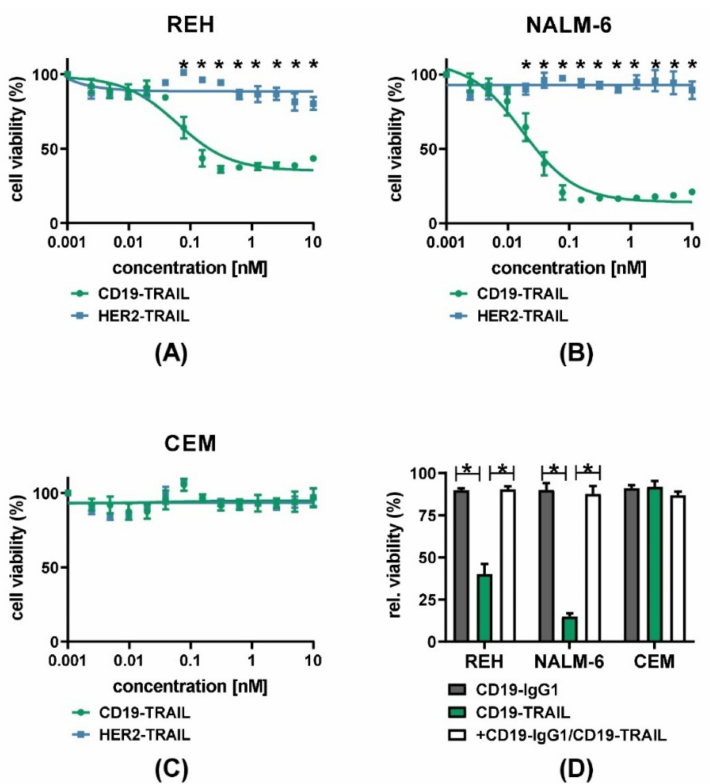
Figure 2. CD19-TRAIL elicits selective anti-proliferative effects in CD19 + ALL-cells: ( A ) CD19 + REH and ( B ) NALM-6 cells as well as ( C ) CD19 − CEM cells were treated with escalating concentrations of CD19-TRAIL or HER2-TRAIL for 72 h, and cell viability was analyzed by MTT assay, two-way analysis of variance; ( D ) Specificity of CD19-dependant cell killing was verified by pre-incubating the cell lines REH, NALM-6, and CEM with CD19-IgG1 antibody (100 nM) for 1 h prior to CD19-TRAIL treatment and measuring cell viability by MTT assay after 72 h, one-tailed Mann–Whitney Test. Graphs depict mean values ± SEM of n = 3 independent experiments. * p <